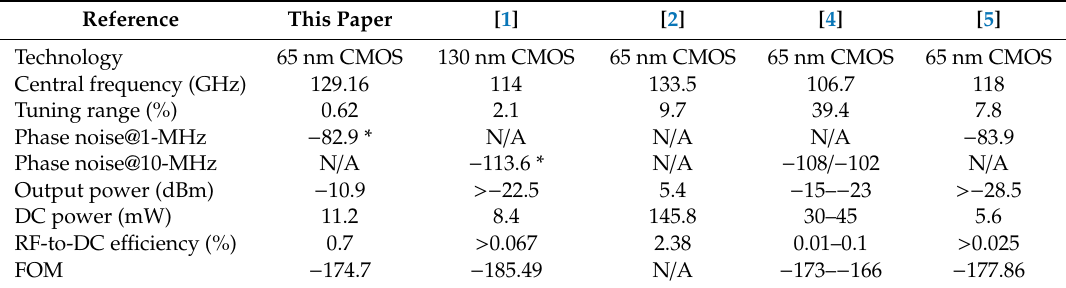
Table 1. Performance comparison with state-of-art